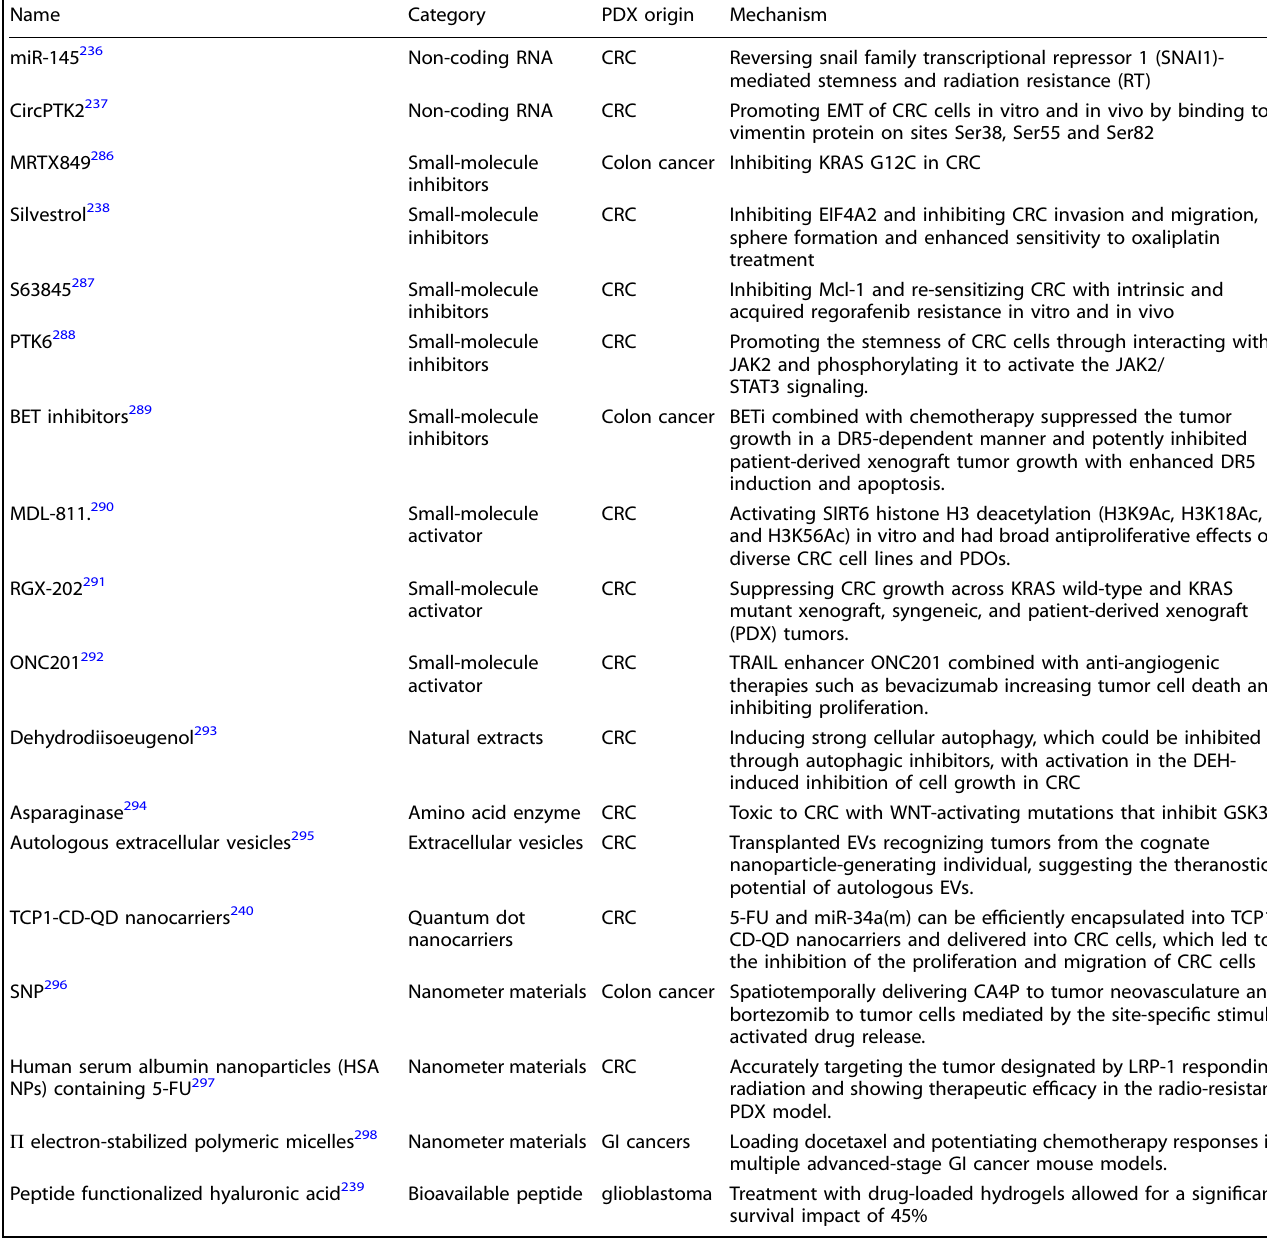
Table 5. PDX model in exploring novel therapy